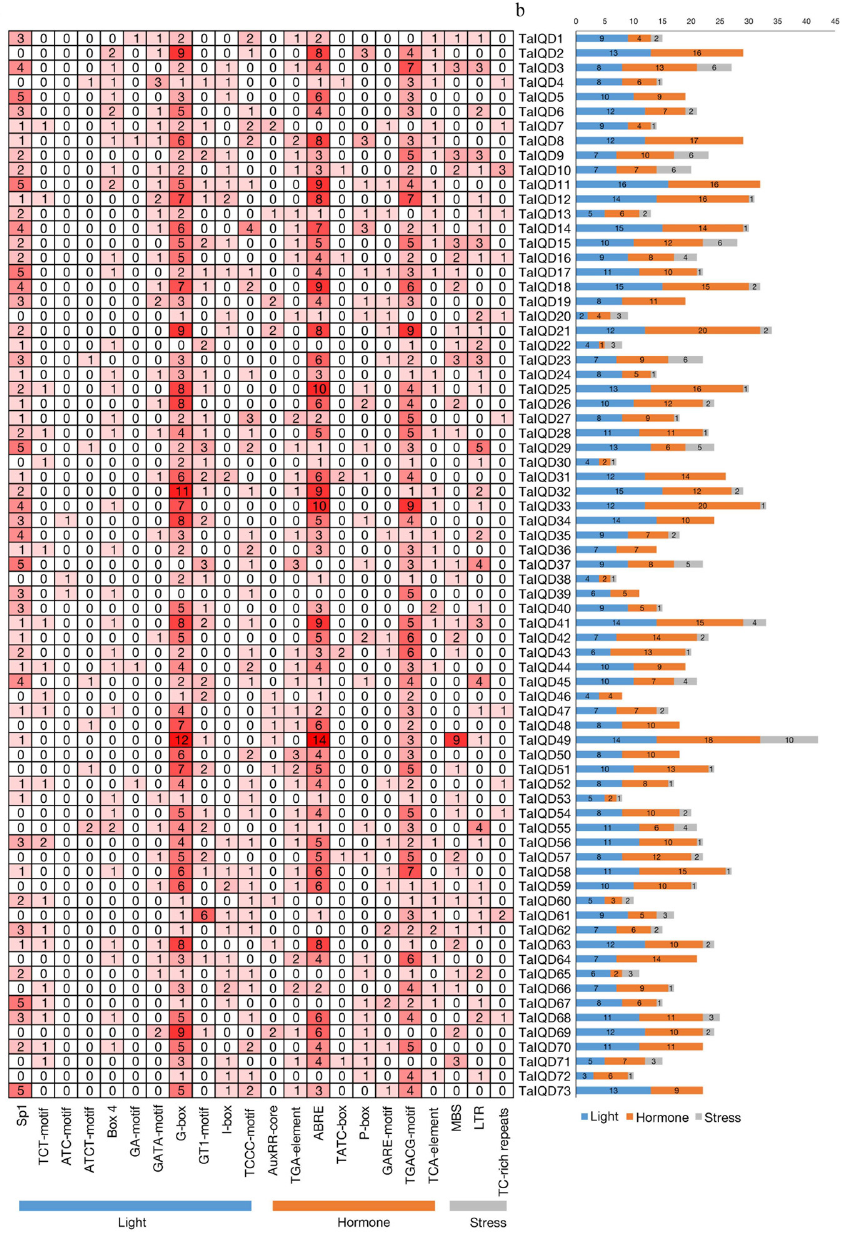
Figure 5. Analysis of cis-acting elements in the promoter regions of TaIQD genes. ( a ) The different col- ors and numbers of the grid indicated the numbers of different promoter elements in these IQD genes. ( b ) The different colored histogram represented the sum of the cis-acting elements in each